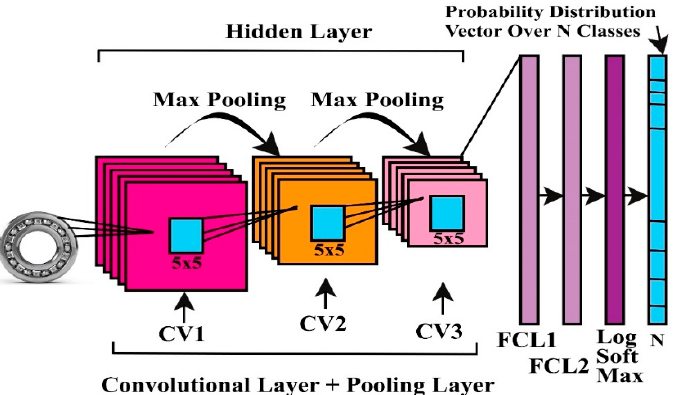
Figure 9. An architecture of convolutional neural network for rotating bearing fault diagnosis.